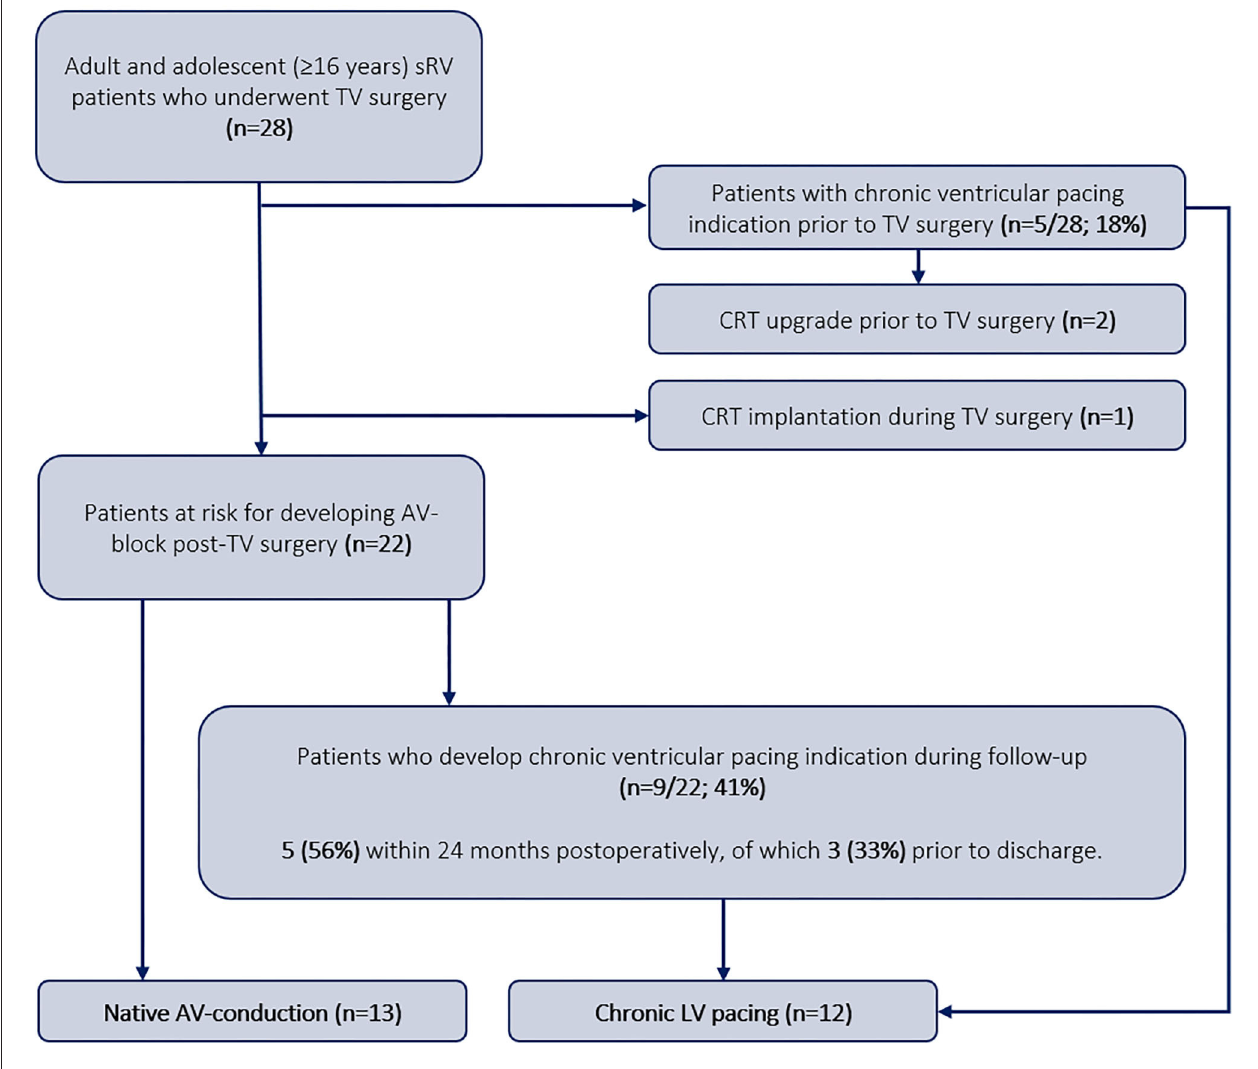
FIGURE 2 | Overview of the study population and the follow-up. sRV, systemic right ventricle; TV, tricuspid valve; CRT, cardiac resynchronization therapy; AV, atrioventricular; LV, subpulmonary left ventricle.